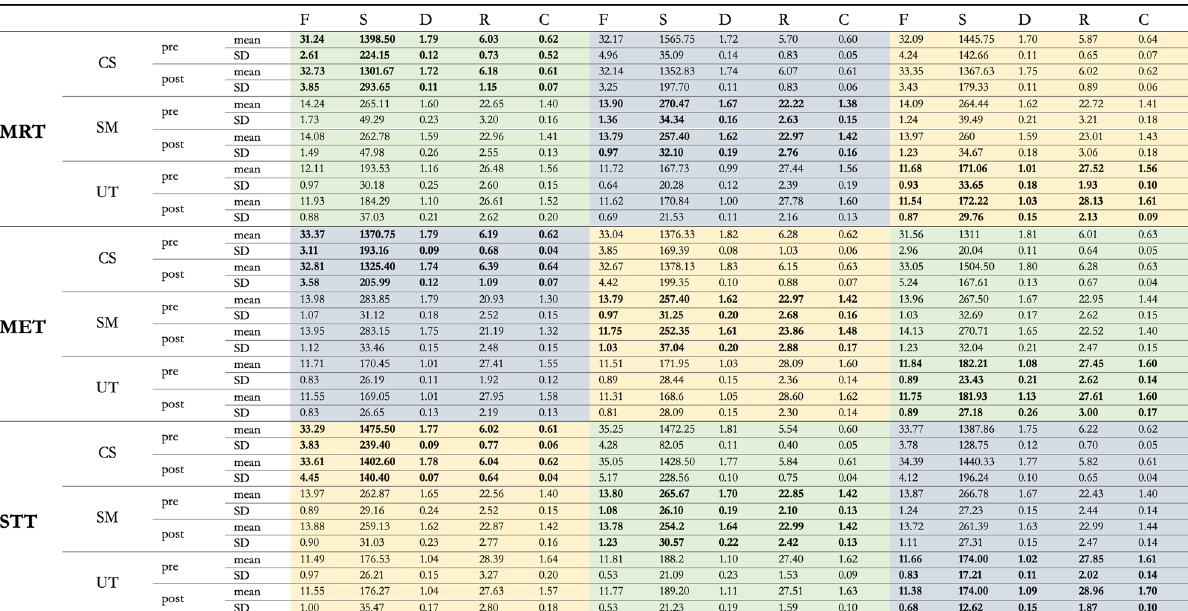
Table 4. Outcomes. Yellow = G1; blue = G2; green = G3. Bold values = treated muscles (intervention values); normal values = untreated muscles (control values). MRT = myofascial release technique; MET = muscle energy